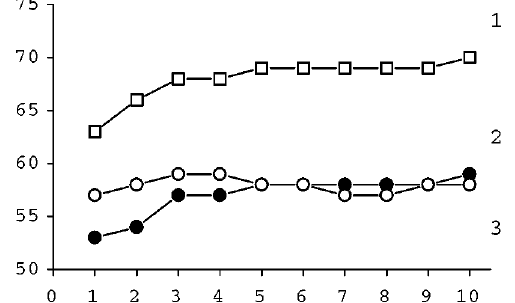
Fig. 1. Cell-by-cell classification data of discriminant functions based on 65 source features. Ten runs of stepwise discriminant func- tion analysis were performed, in which 1 to 10 of the source features were allowed to build functions for classification of normal epithe- lium versus normal-appearing borders of invasive laryngeal cancer with dense lymphocytic stroma infiltrate (1). These functions were then applied to classification of normal epithelium versus normal borders of invasive cancer with low-density lymphocytic